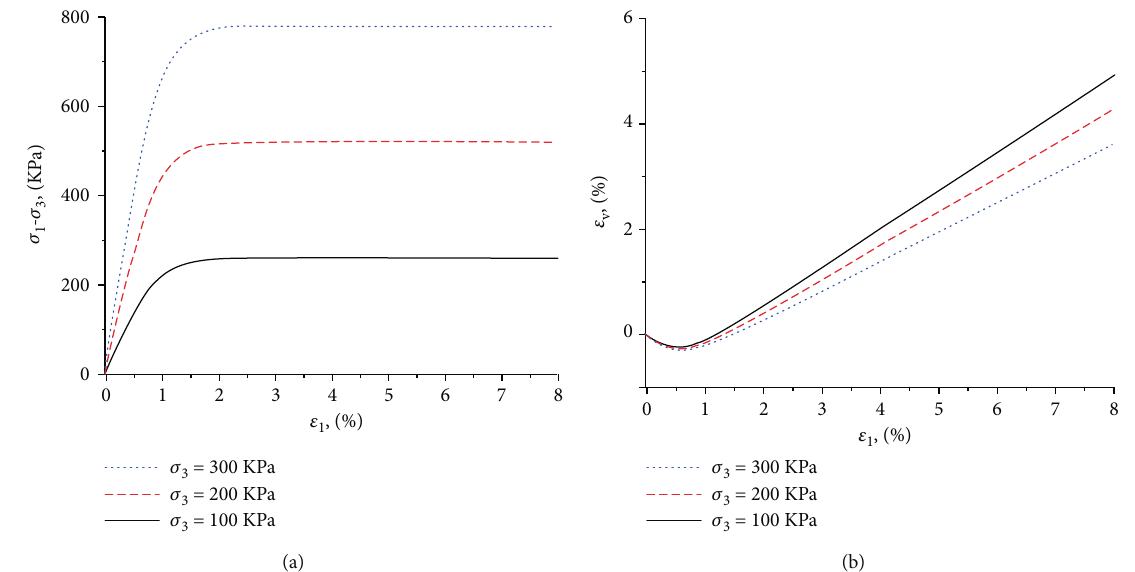
Figure 7: Simulation of triaxial tests for various con fi ning pressure: (a) deviatoric stress vs. axial strain; (b) volumetric strain vs. axial